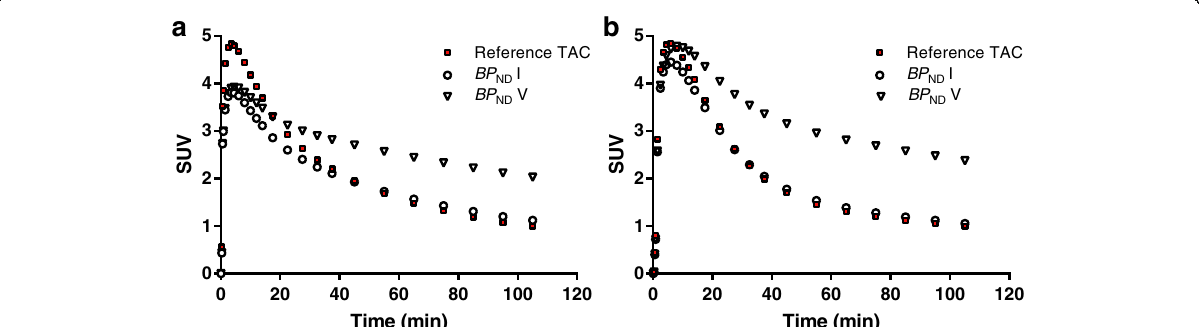
values and 2T4k_V b -generated reference tissue TACs for a [ 18 F]flutemetamol ND